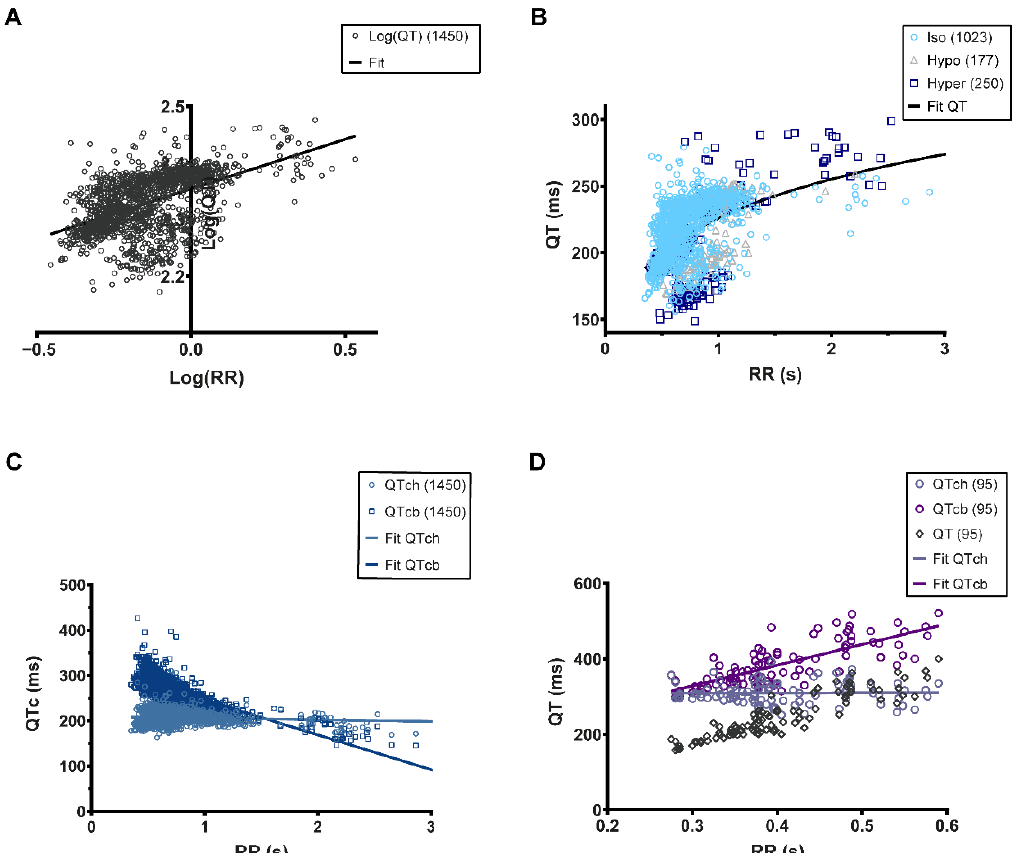
Figure 4. QT-RR relationship fitting. ( A ), Linear fitting (black line) of the Log(QT)–Log(RR) rela- tionship). The slope of the relationship is 0.2064; ( B ), Non-linear fitting (black line) of the QT-RR relationship using the characteristics of the fitting shown in ( A ); ( C ), QTc-RR relationship using Holzgrefe’s correction formula (QTch) and Bazett’s equation (QTcb). These relationships were linearly fitted (blue-grey line: QTch; navy line: QTcb); ( D ), QT-RR relationship from the data published in Milan et al., 2006. The QT-RR raw data are in open black diamonds. The QT corrected by the Holzgrefe’s equation, QTch, are lila c opened circles, and the corresponding linear fitting is the lilac line, while the QT corrected by Bazett’s formula are opened purple circles and the corresponding linear fitting if the purple line. The number of individual QT-RR pairs is presented in the upper right corner of each graph.